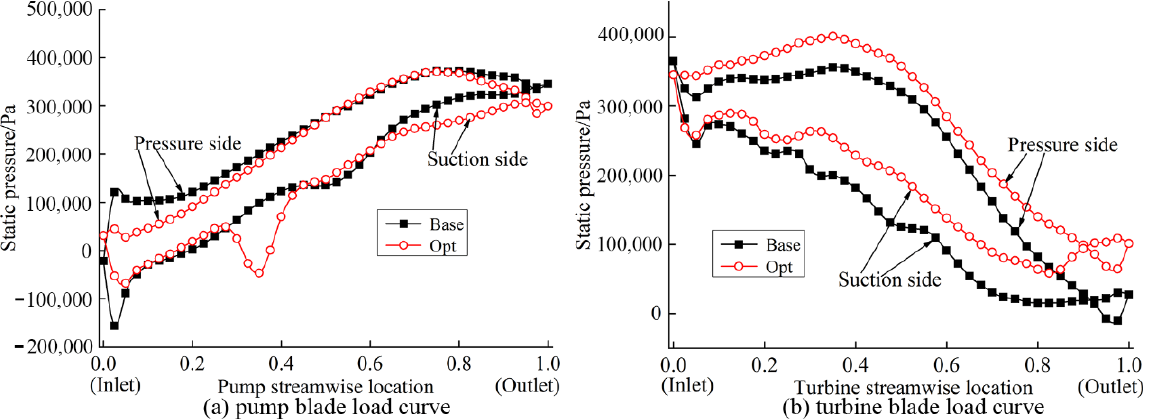
Figure 16. Comparison of blade load before and after optimization under peak-efficiency operating conditions from inlet (0) to outlet (1).